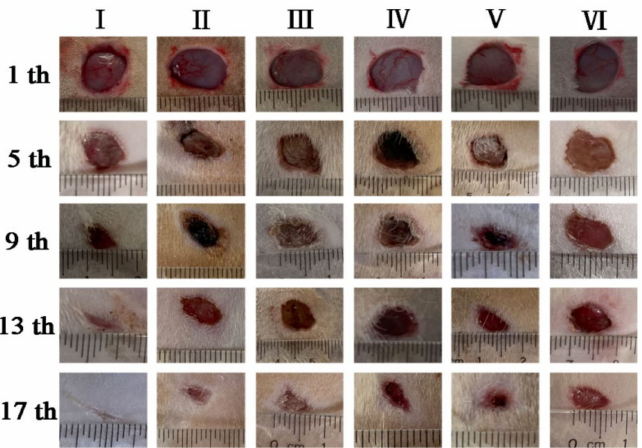
Figure 10. Macroscopic photographs of wounds at 1st, 5th, 9th, 13th and 17th day after full-thickness (( I ) PNIPAAm-PVA/CS-CuS with illumination, ( II ) PVA/CS hydrogels-PVA/CS-CuS with illumi- nation; ( III ) PNIPAAm-PVA/CS-CuS without illumination; ( IV ) PVA/CS nanofiber membrane; ( V ) PNIPAAm-CuS hydrogels; ( VI ) treated with sterile gauze).